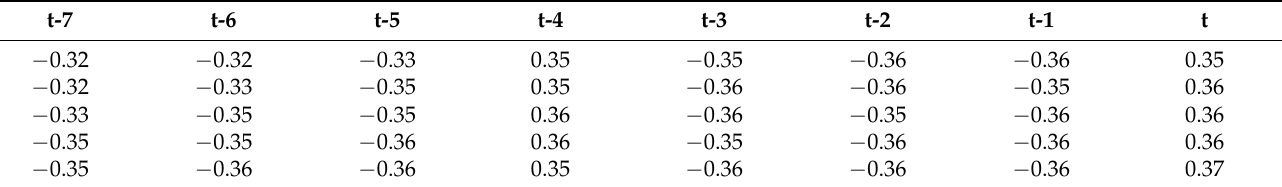
Table 3. Transformation of time series to supervised problem